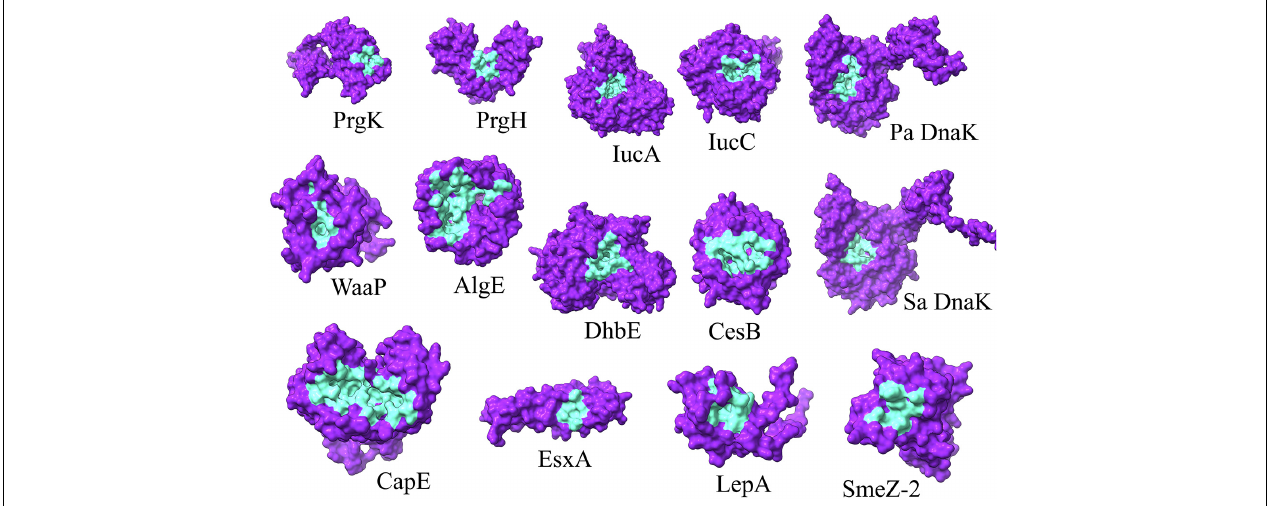
FIGURE 1 | 3D representation of the P2Rank predicted druggable pockets (cyan) of selected proteins (indigo). Pa and Sa denote P. aeruginosa and S. aureus ,